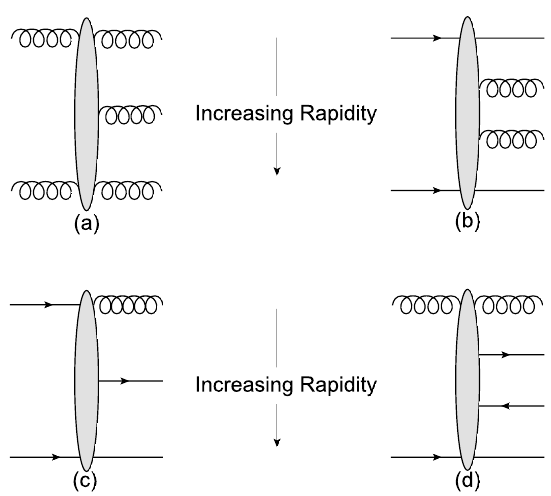
Figure 2. The particle flavour and momentum configurations in (a) and (b) allow the maximum number of t -channel gluon exchanges and so contribute at LL, while those in (c) and (d) require one t -channel quark-exchange and hence contribute at NLL.